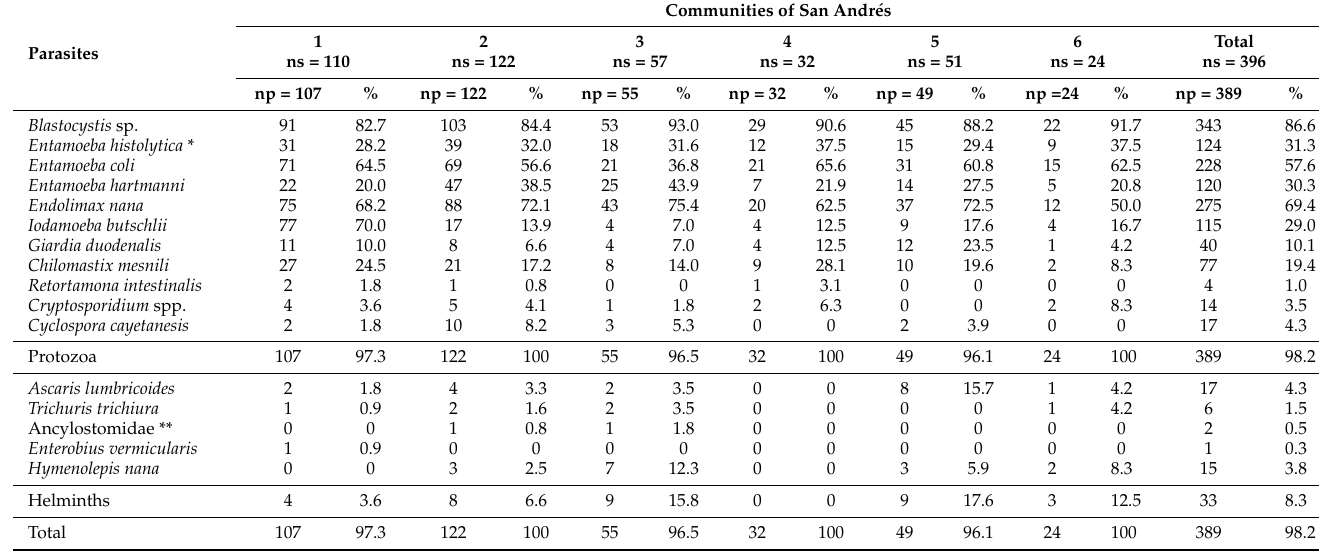
Table 3. Frequency of intestinal parasites in residents of the San Andres